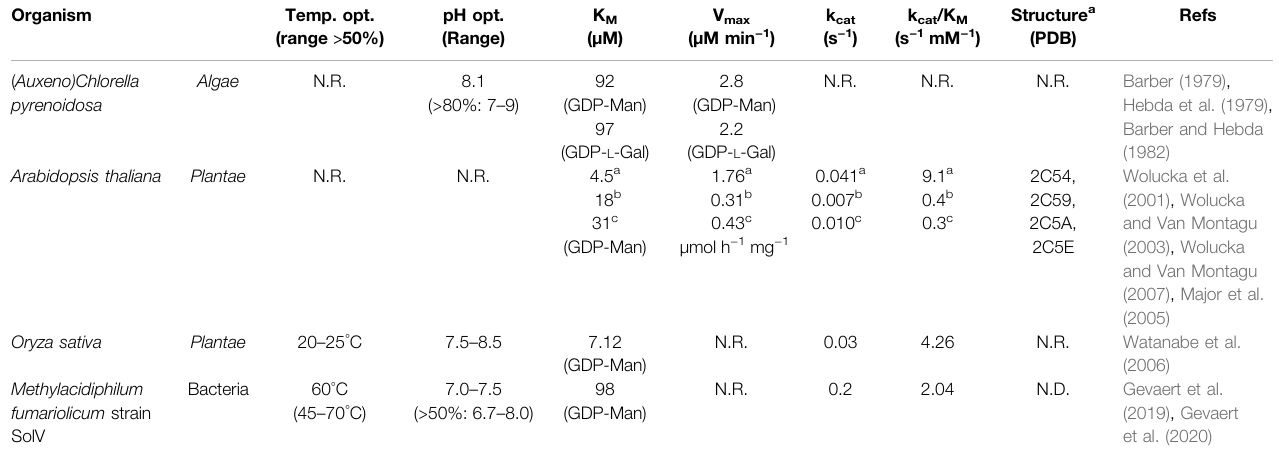
TABLE 1 | Overview of biochemically characterized GM35E Organism Temp. opt. (range >